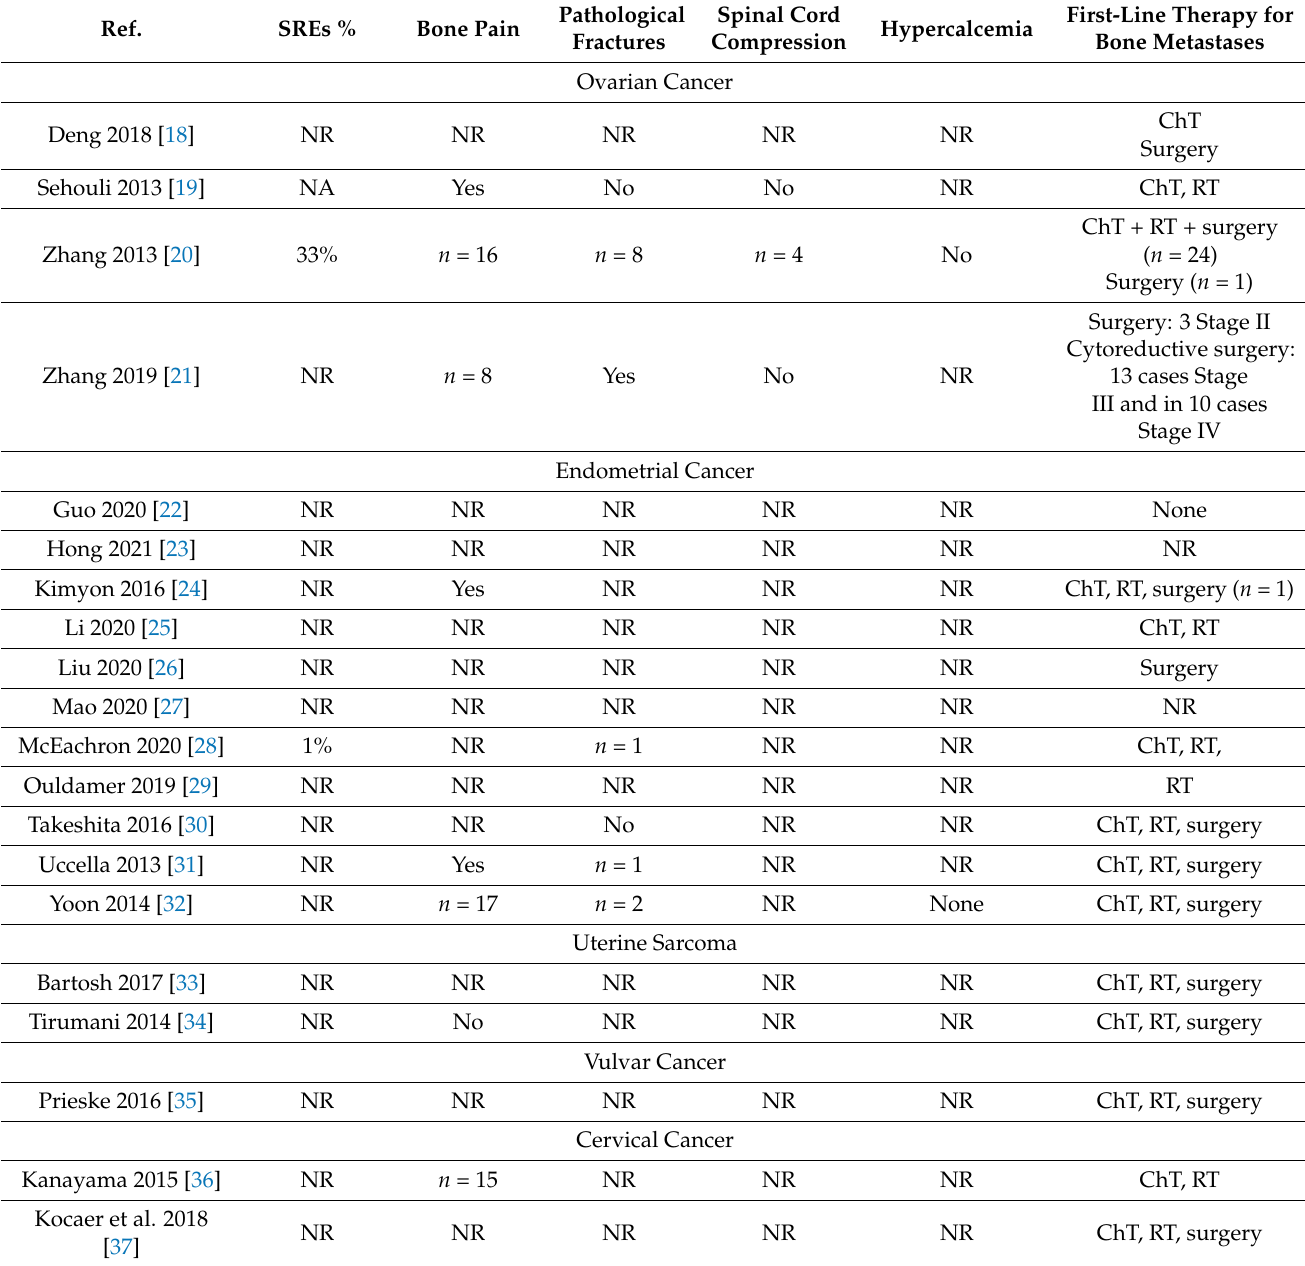
Table 4. Development of complications and skeletal-related events in patients with GC bone metastases included in the review. Ref. SREs % Bone Pain